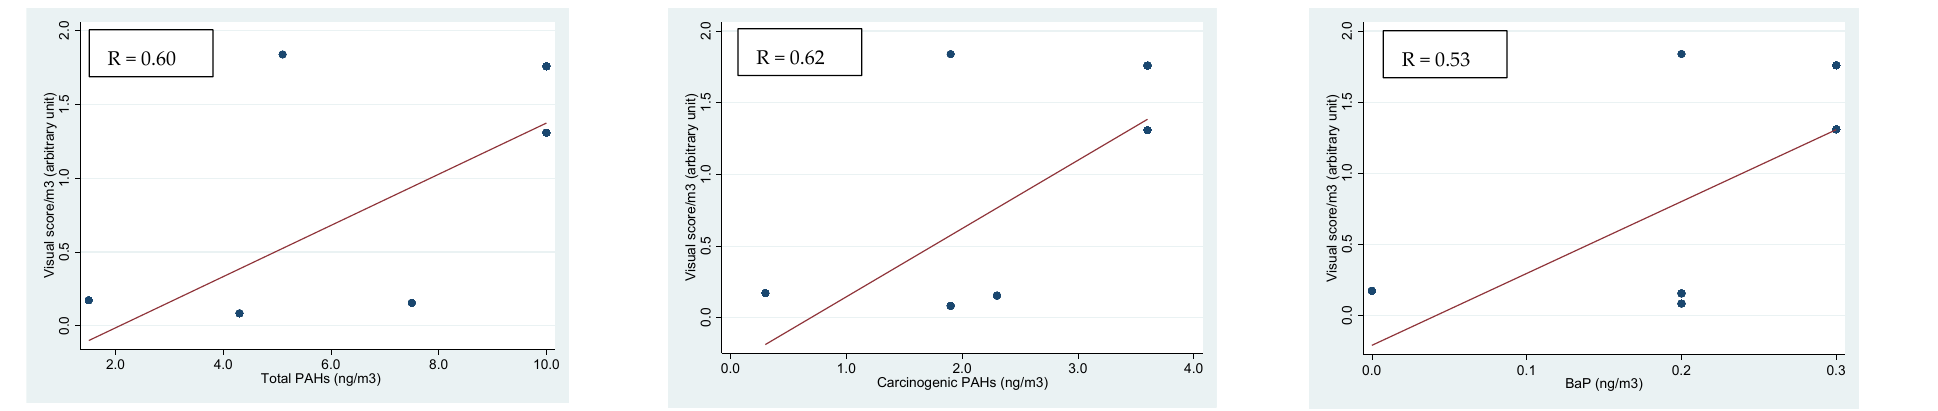
Figure 1. Linear regressions of mutagenicity in the Ames test with the TA98 strain on total PAHs, carcinogenic PAHs and BaP concentration in PM 0.5 and the Spearman’s correlation coefficients ( p < 0.001 for all comparisons).